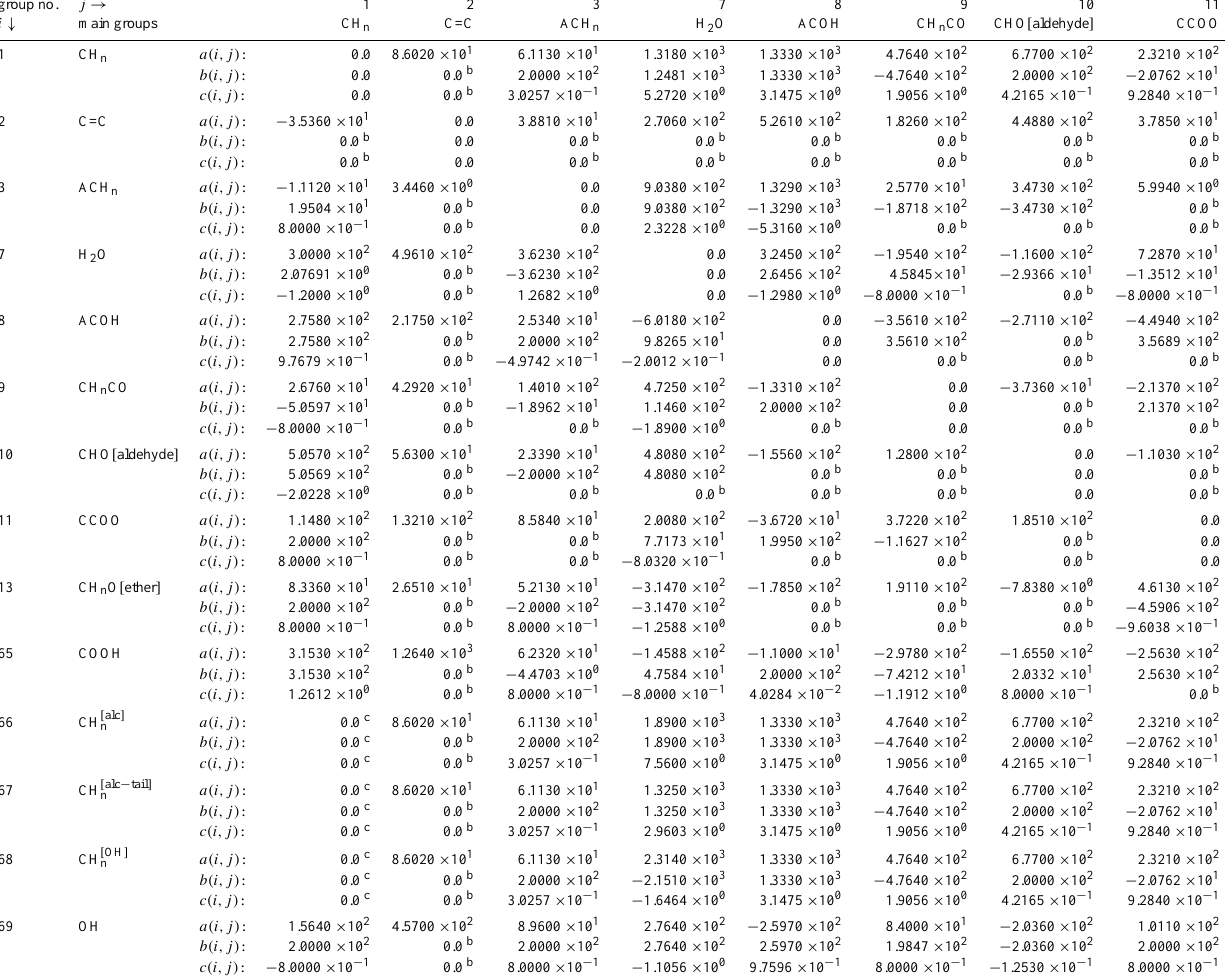
Table 2. Matrix of AIOMFAC short-range group interaction parameters. Parameter values for a(i,j) (units of K) are from the literature a , b(i,j) (units of K), and c(i,j) (dimensionless) are determined in this study. group no. j